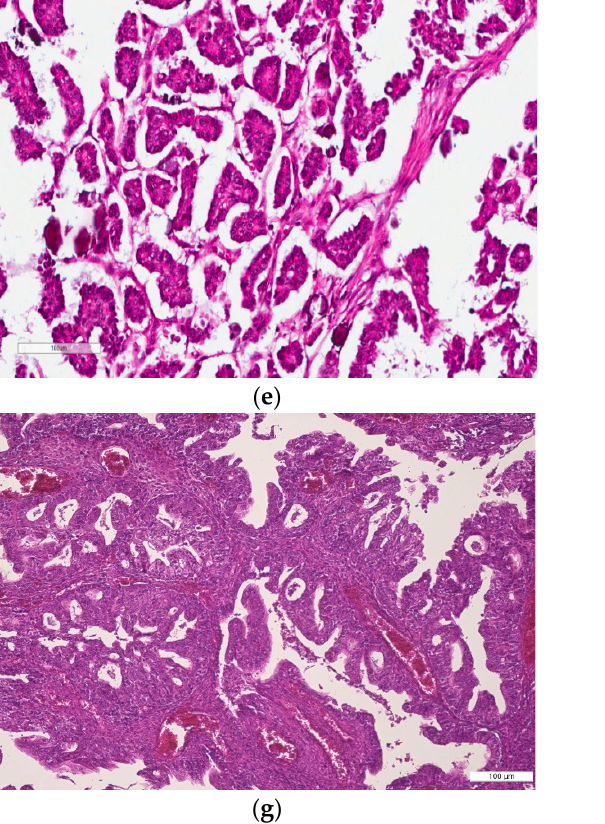
Figure 2. ( a – h ) Histologic features and BMI-1 expression in NEOC group in different ovarian tumor subtypes: ( a , b ) MOC: ( a ) atypical mucin-producing tumor cells with an infiltrative pattern of invasion (H&E, magnification 10×), ( b ) negative BMI-1 staining in tumor stroma of MOC (magnification 10x); ( c , d ) HGSC: ( c ) variation in cellular size and shape, marked nuclear atypia, dense fibrous stroma, and inflammation around the tumor nests (H&E, magnification 10×), ( d ) strong BMI-1 cytoplasmic staining of tumor stroma in HGSC (magnification 10×); ( e , f ) LGSC: ( e ) micropapillary growth with minimal nuclear atypia in LGSC (H&E, magnification 10×), ( f ) moderate BMI-1 cytoplasmic staining of tumor cells and stroma in LGSC (magnification 10×); ( g , h ) LGEC: ( g ) papillary and glandular differentiation in LGEC (H&E, magnification 10×), ( h ) strong BMI-1 cytoplasmic staining of tumor cells and stroma in LGEC (magnification 10×).